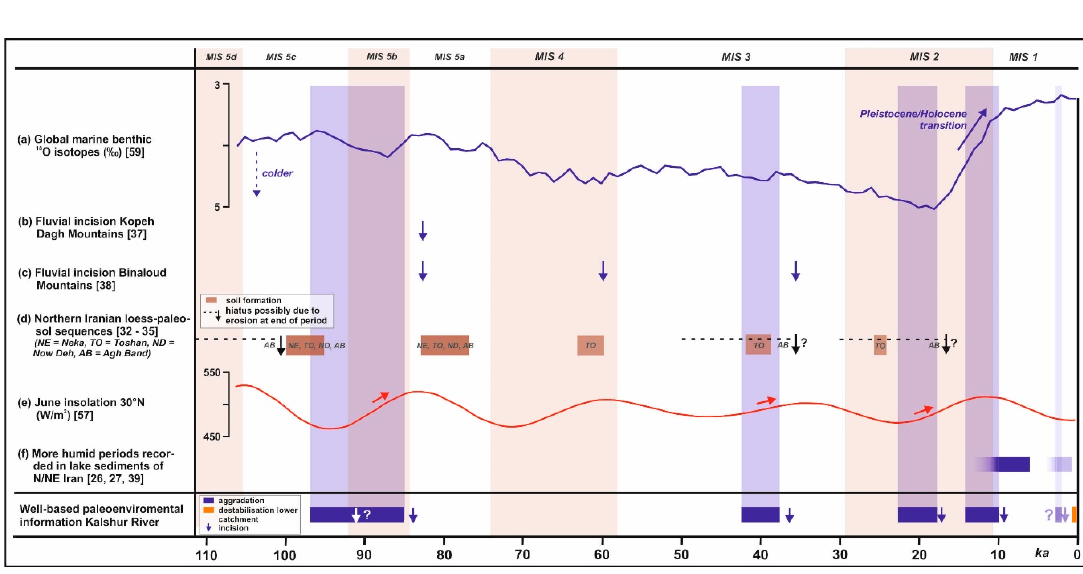
Figure 12. Comparison of well-based paleoenvironmental information from the Kalshur river system (lower part) with regional and over-regional paleoenvironmental data: ( a ) Global marine benthic 18 O isotopes, ( b ) Fluvial incision Kopeh Dagh Mountains, ( c ) Fluvial incision Binaloud Mountains, ( d ) Northern Iranian loess-paleosol-sequences, ( e ) June insolation 30° N, ( f ) More humid periods recorded in lake sediments of N/NE Iran. Locations of the regional study sites please see in Figure 1.